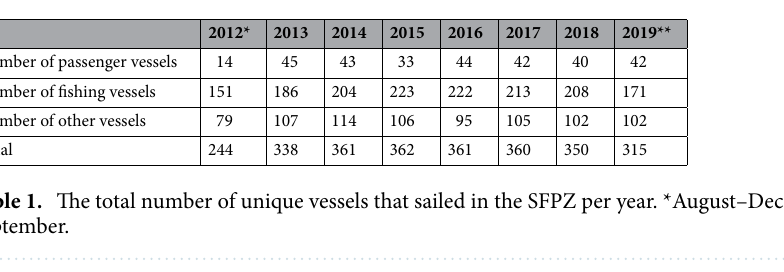
Figure 2. ( a ) Number of vessels in SFPZ from August 2012 until September 2019. Green: fishing vessels, yellow: passenger vessels (oversea and expedition cruise ships), grey: other categories (research, container ships, bulk carrier, etc.…). ( b ) The number of fishing vessels per month over the study period.